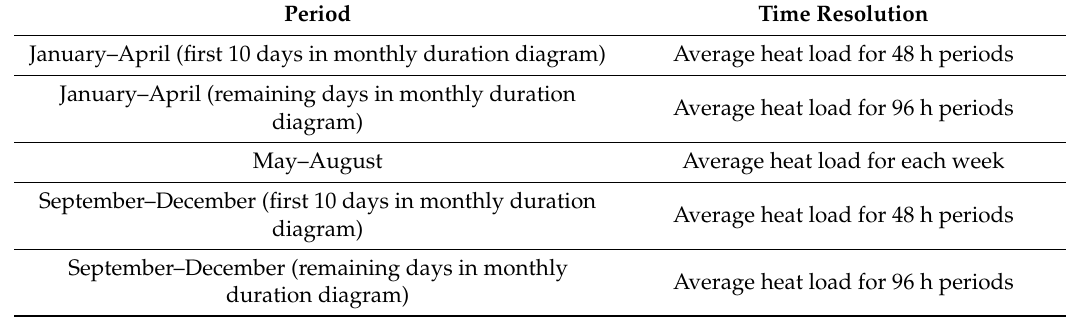
Table 4. Time division in the model.